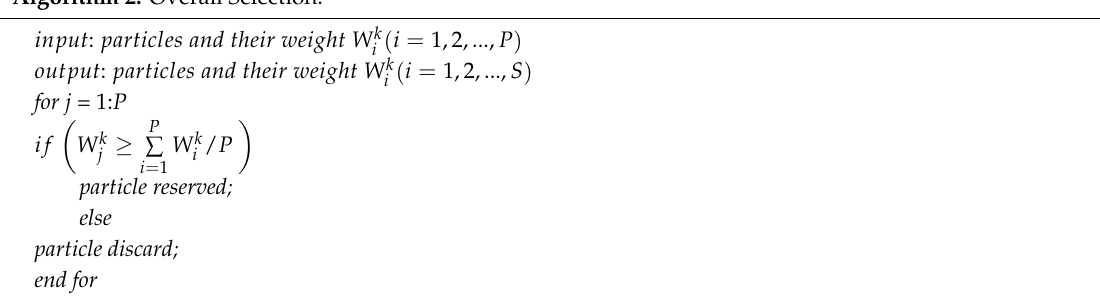
Algorithm 2. Overall